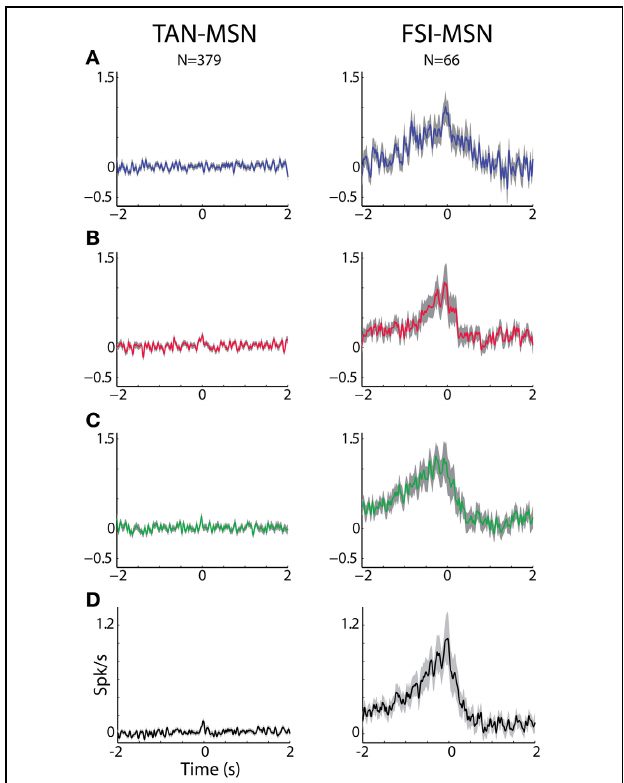
FIGURE 6 | MSN-FSI and MSN-TAN correlation is not dependent on task event. (A) Normalized CCH (using the PSTH predictor) averaged over all interneurons to MSN pairs for the reward event. The MSN (trigger cell) discharge is at time zero. Ordinate: conditional firing rate of the TAN or FSI (reference cell), given a spike of the interneuron at time zero. (B) Normalized CCH averaged over all interneurons to MSN pairs for the aversive event. Same conventions as in (A) . (C) Normalized CCH averaged over all interneurons to MSN pairs for the neutral event. Same conventions as in (A) . (D) Normalized CCH (using the PSTH predictor) averaged over behavioral events for all interneurons to MSN